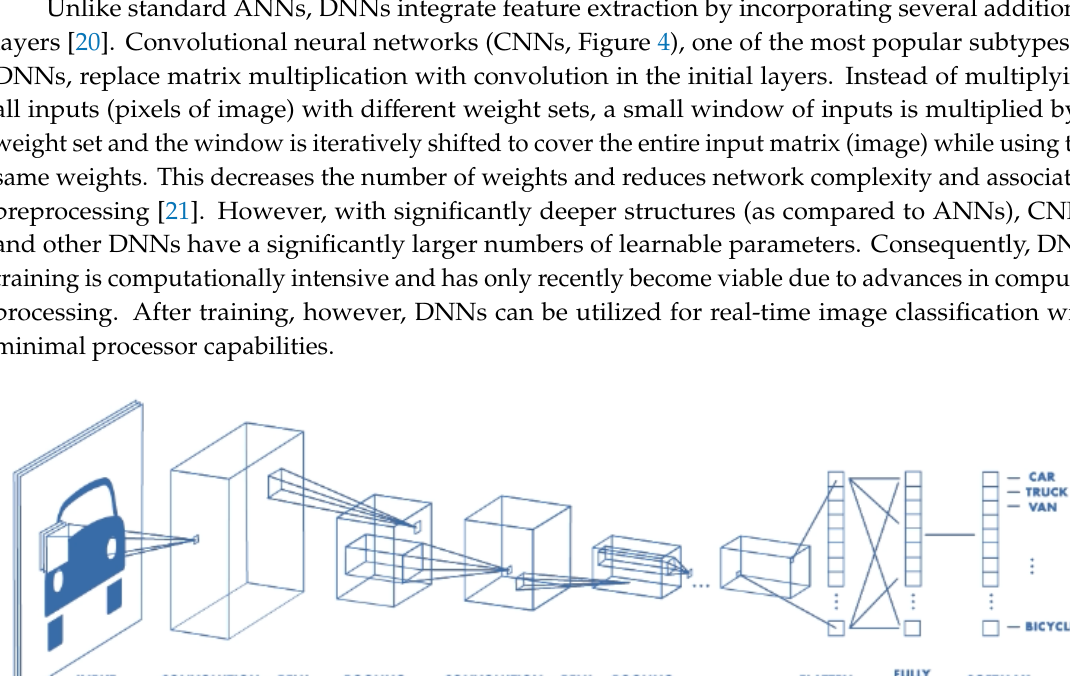
Figure 3. Architecture of a feedforward artificial neural network. Figure 3 . Architecture of a feedforward artificial neural network. Figure 3 . Architecture of a feedforward artificial neural network.